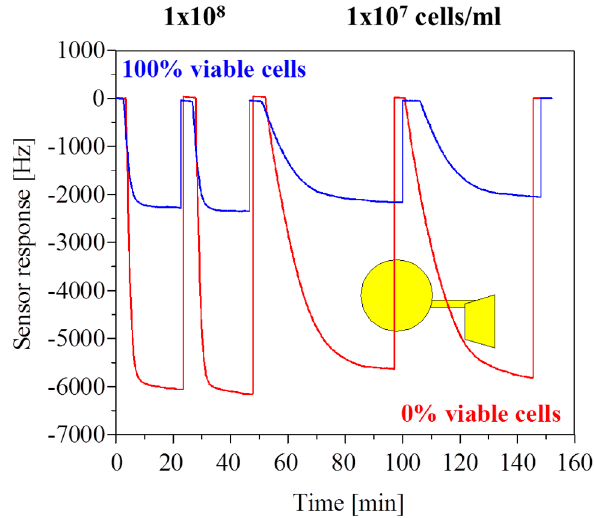
Figure 3. Superimposed differential measurements with a conventional QCM electrode layout for high S. cerevisiae suspensions in PBS buffer with 100% viable cells (blue) and non-viable cells (red).